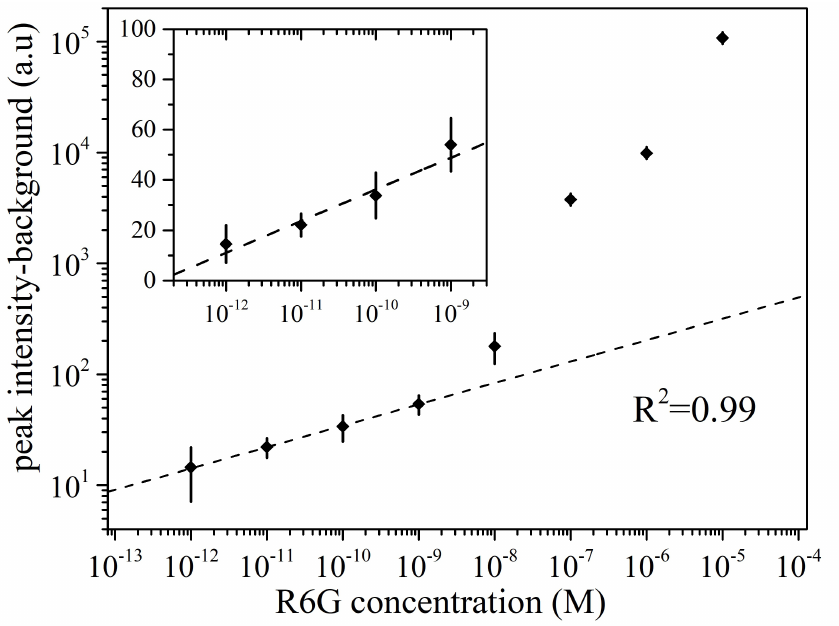
Figure 8. PL peak signal for various R6G concentrations (in log-log scale) for silver dendrites on SiNWs enriched with AuNPs. The plot shows the background-subtracted maximum PL signal. Analyte-free substrates are used to obtain the background